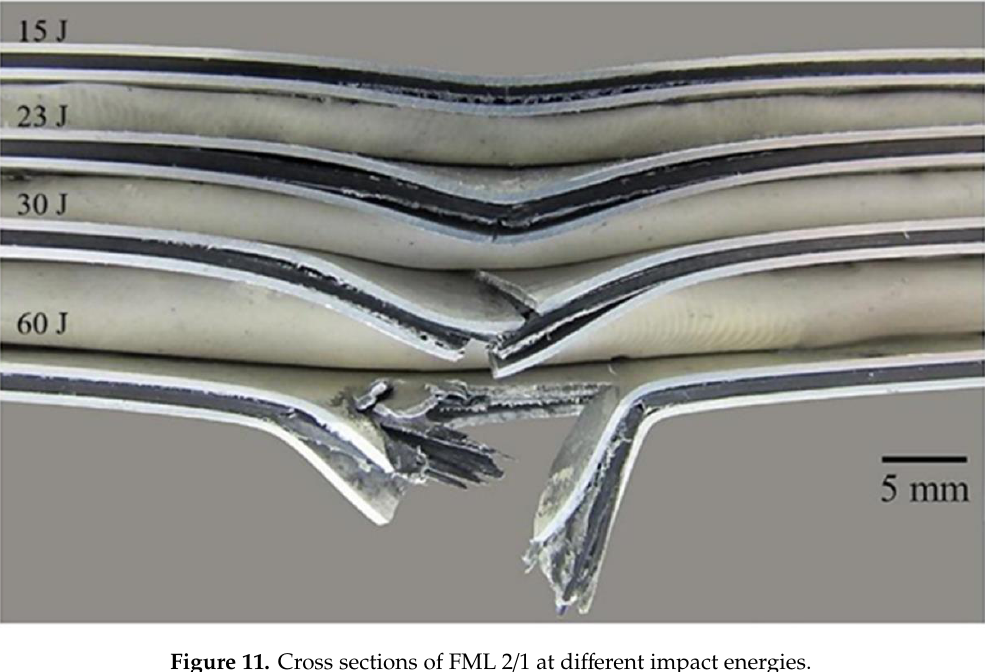
Figure 11. Cross sections of FML 2/1 at different impact energies. Materials 2020 , 13 , x FOR PEER REVIEW